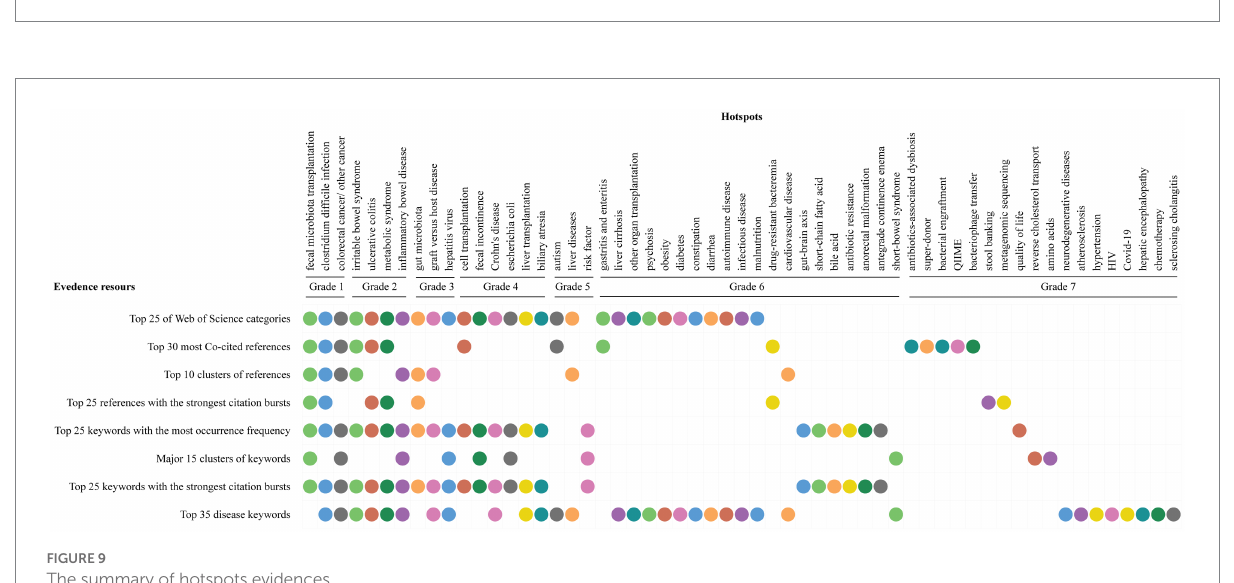
FIGURE 9 The summary of hotspots